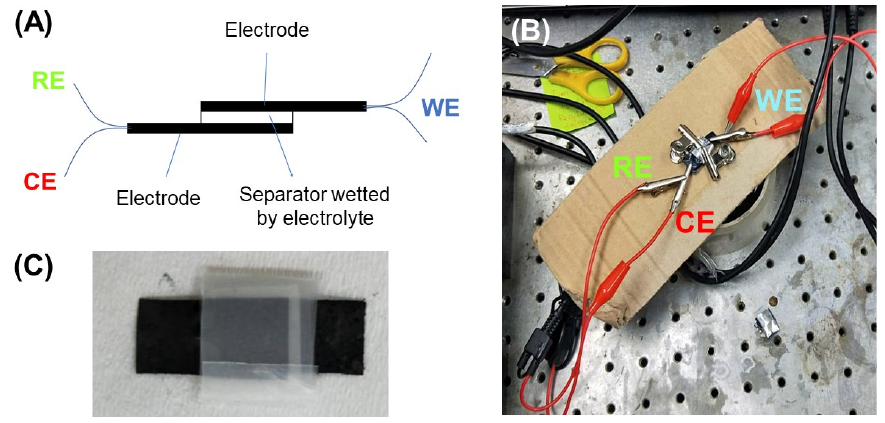
Figure 1. ( A ) A scheme and ( B ) an image of two ‐ electrode configuration. ( C ) An image of a two ‐ electrode cell.